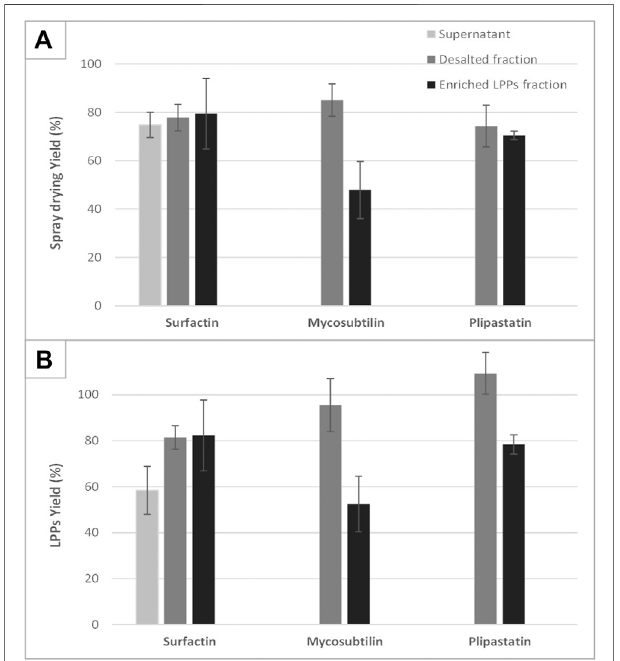
FIGURE3| Overviewoftheperformancesofthespray-dryingprocessin terms of process yield (A) and lipopeptide speci fi c yield (B) . The drying performances of the three lipopeptides sampled at different steps of the puri fi cation process (supernatant, dia fi ltered fraction, and enriched lipopeptides fraction) are compared with each other and with reference samples corresponding to spray-dried and resolubilized commercial lipopeptides. Any analyzable dry product was obtained after spray-drying of mycosubtilin or fengycin supernatant. Each drying experiment wasperformed on three distinct samples coming from different production batches; mean values and standard deviation are presented.